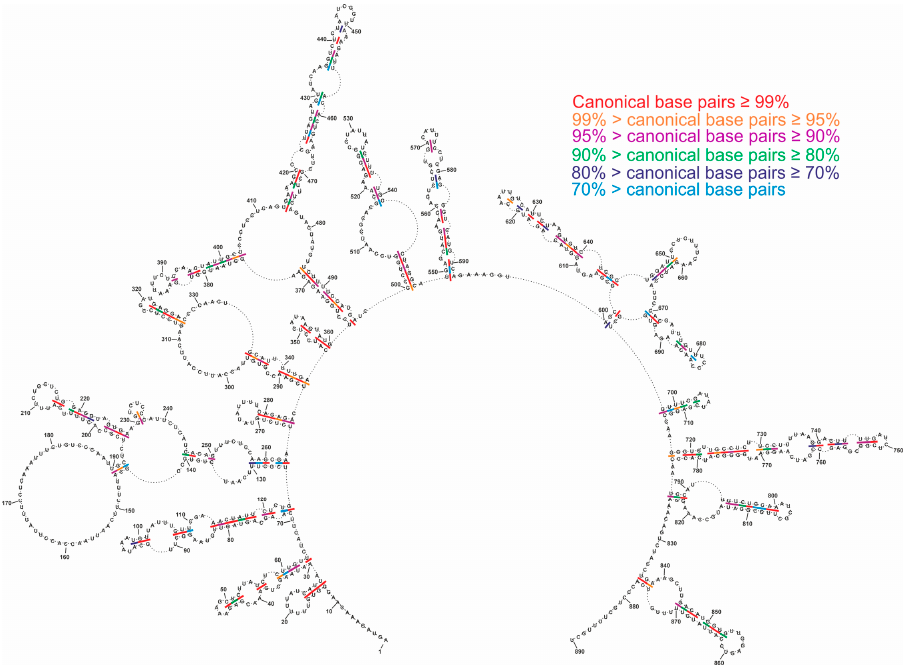
Figure 8. Conservation of vRNA8 local structure across type A influenza. Base pair conservations were marked based on the analysis of 34,248 IAV strains obtained from the NCBI Influenza Virus Database. Table 1. The motifs with the highest, ≥ 95%, conservation of the base-pairing within IAV, predicted in local and global MFE structures. The motifs predicted in both local and global structures are bolded.